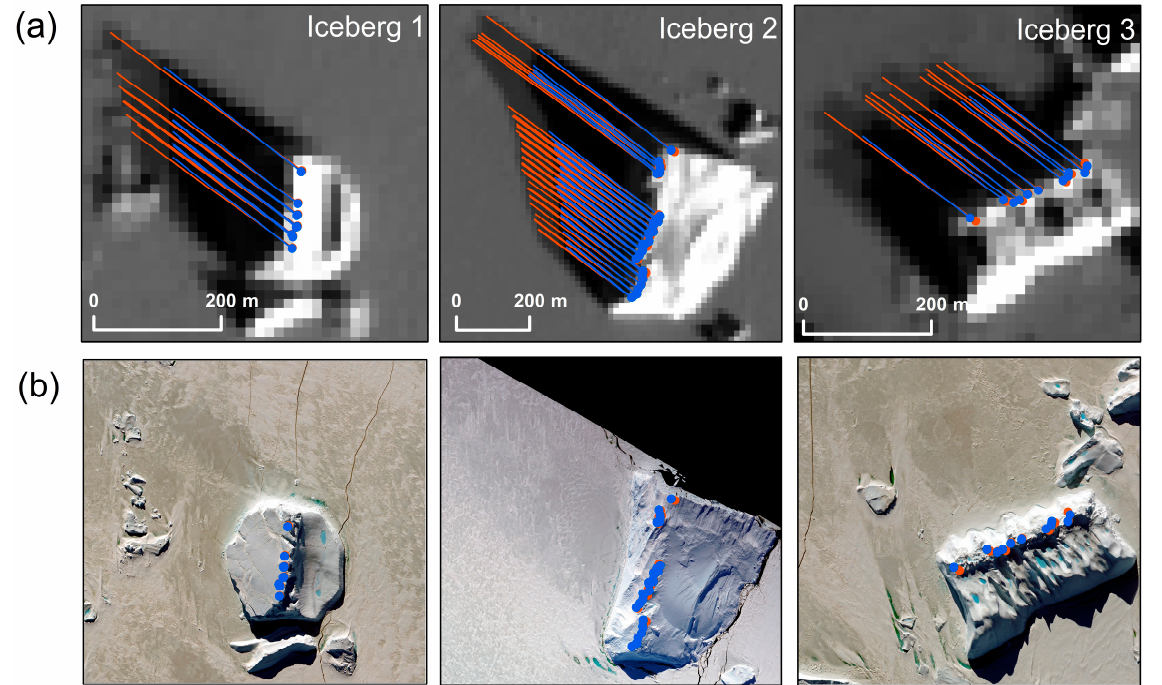
Figure 6. The three capsized icebergs on ( a ) the Landsat-8 15-m resolution Panchromatic overlaid images with 50% transparency taken on 7 September, 2016, and 16 September, 2016; ( b ) the 0.17-m resolution UAV images on 13 December 2016. The blue and orange lines show the shadow length extraction results for the Landsat-8 images taken on 7 September 2016 and 16 September 2016, respectively. The blue and orange dots show the iceberg shadow formation points extracted on 7 September 2016 and 16 September 2016, respectively.